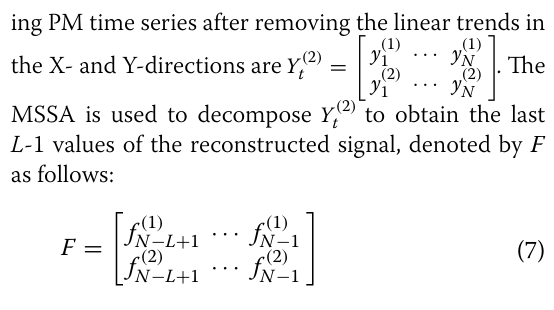
Method of prediction